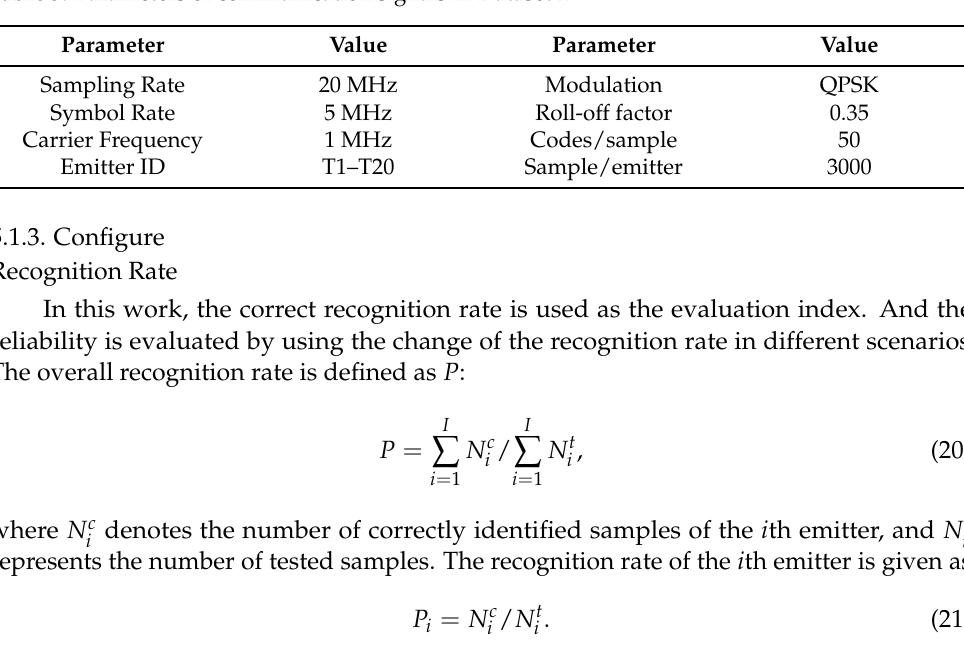
Table 3. Parameters of communication signals in Dataset